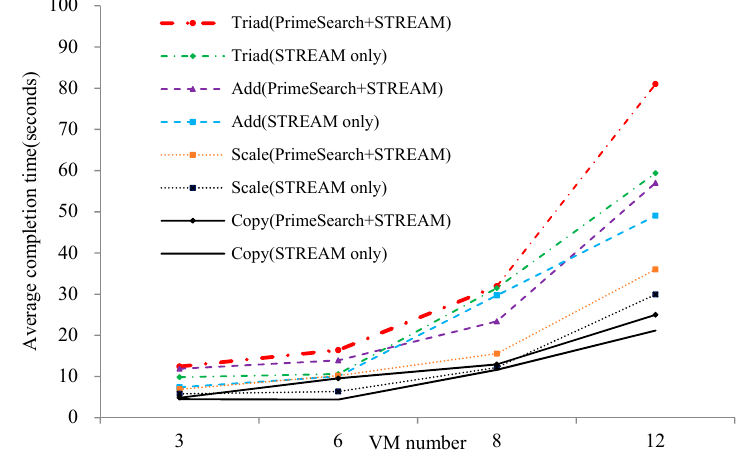
Figure 13. Average completion time of STREAM (server #3).